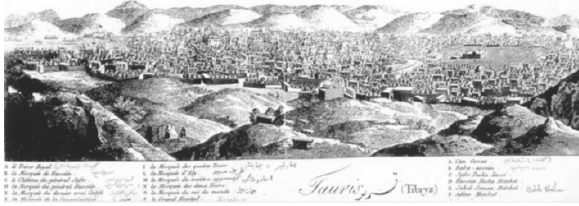
Figure 17. Sketch of Tabriz in Safavid Era; “Chardin Itinerary” (Chardin, 1956, p. 409).